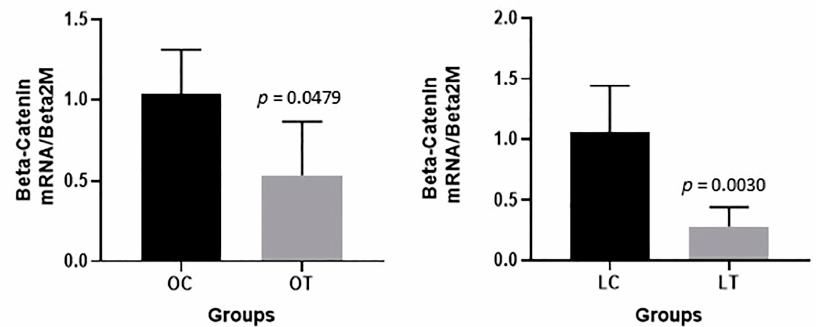
Figure 8. β -Catenin expression in the gut of animals: obese control (OC), obese treated (OT), lean control (LC) and lean treated (LT) groups.